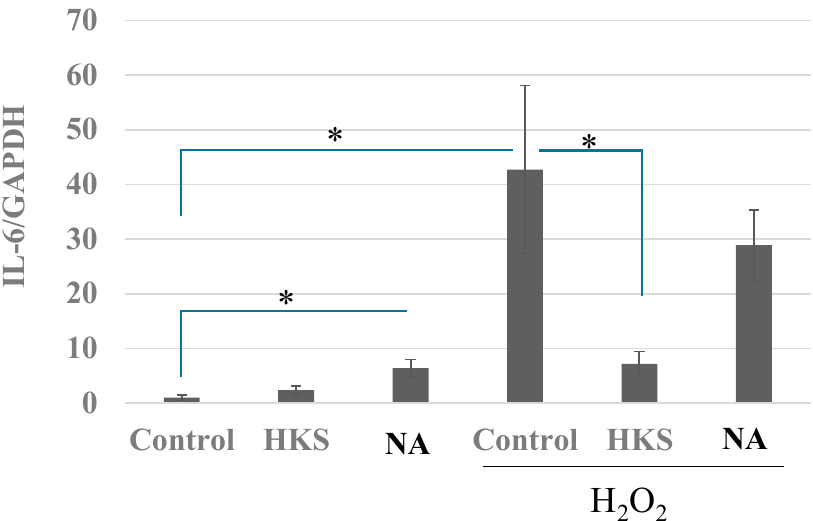
Figure 5. Bifidobacterium breve MCC1274 extracts and niacin prevent the increase in IL-6 expression induced by oxidative stress. The SH-SY5Y cells were exposed to HKS ( B. breve MCC1274 heat-killed cell extracts at 1% v/v final concentration) or niacin (NA, 100 nM), with or without H 2 O 2 (200 µ M), for 24 h. Human interleukin-6 (IL-6) mRNA expression relative to human GAPDH expression was determined by RT-PCR. The data are shown as the mean + SD of four replicates. * p < 0.05 (Student’s t-test for two-group or non-repeated measures ANOVA with the Bonferroni post hoc test for multiple-group comparison, respectively).